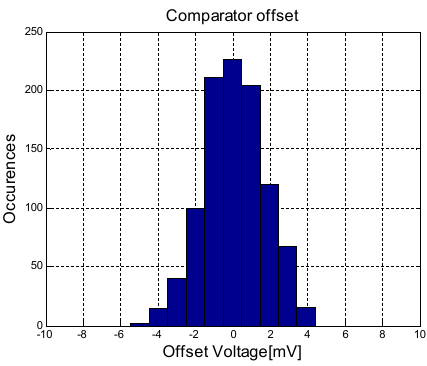
Figure 6. Comparator offset.